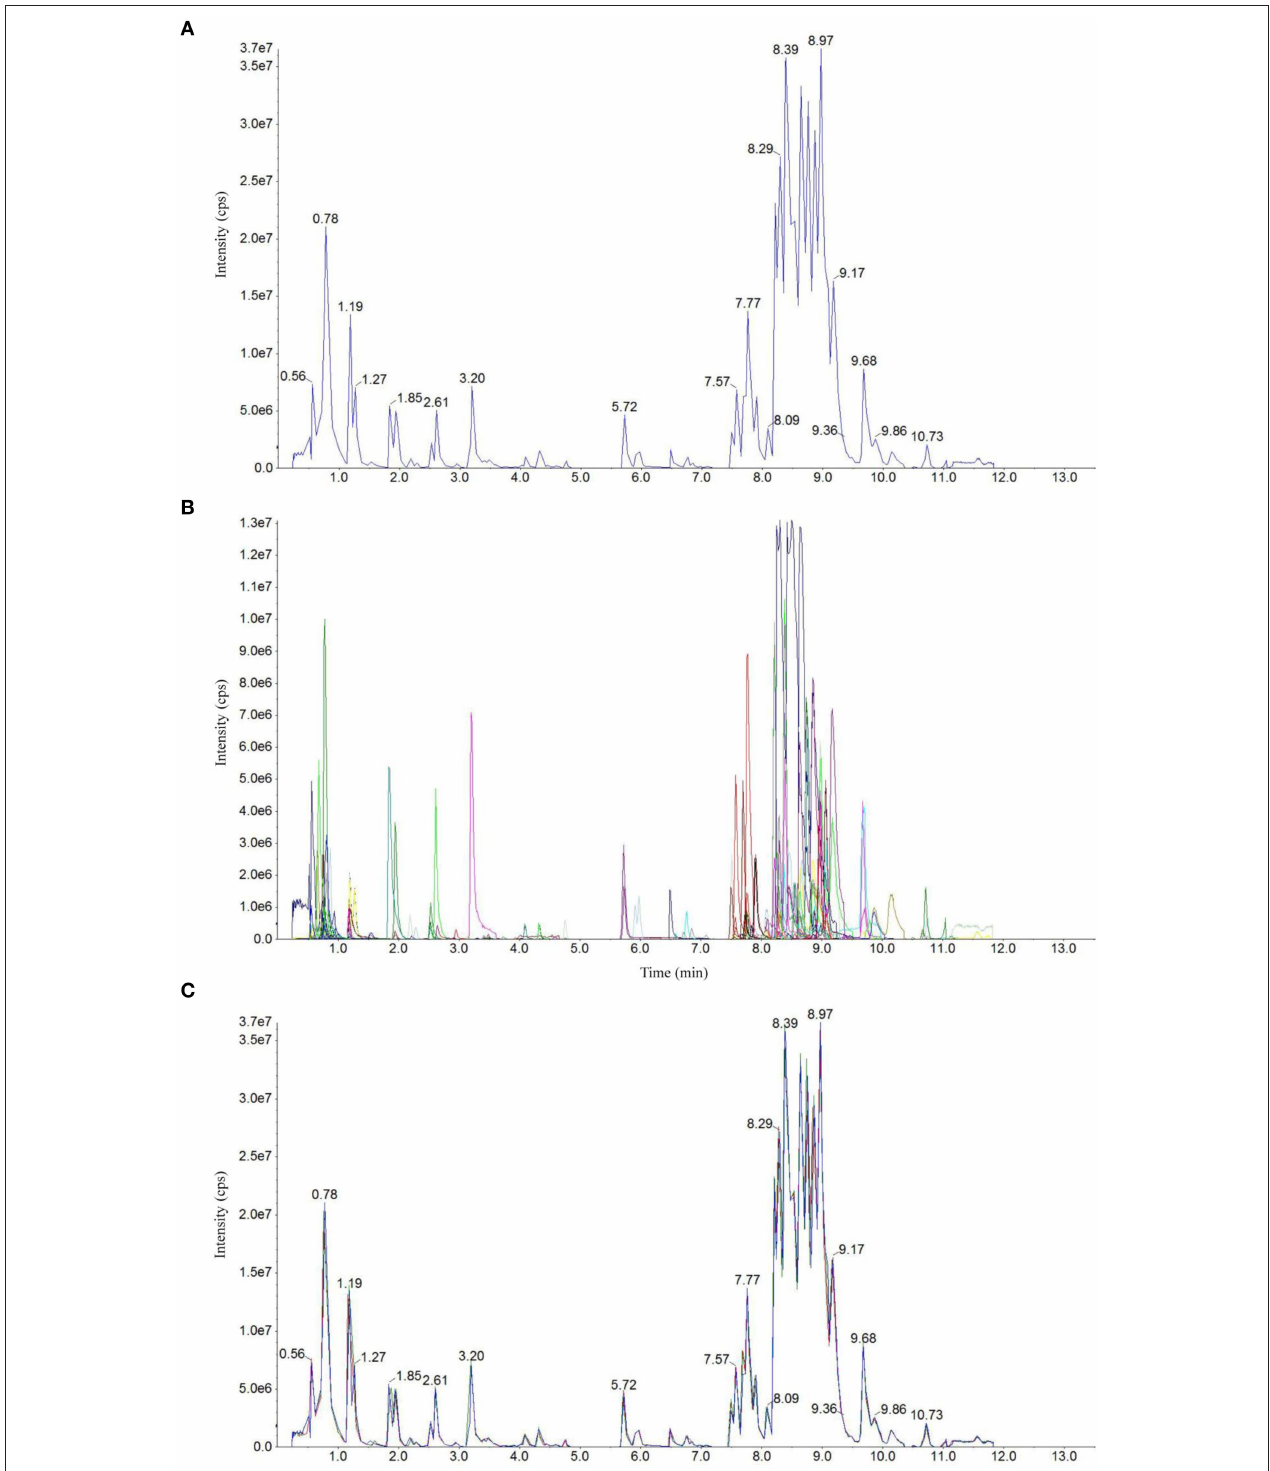
FIGURE 1 | Detection of metabolites in UPLC–ESI-MS/MS. Total ion chromatographs of one quality control (QC) sample by mass spectrometry detection (A) , multipeak detection plot of metabolites in the multiple reaction monitoring (MRM) mode (B) , and overlapping map by QC sample (C) .